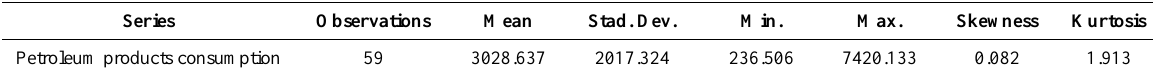
Table 1. Descriptive statistics of annual petroleum products consumption (measured in thousands metric